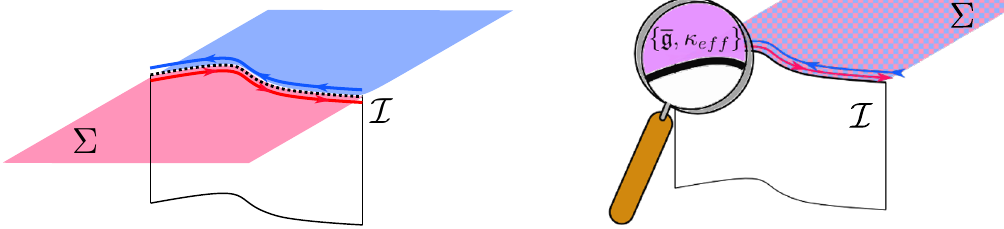
Figure 2 . On a Cauchy slice (cid:6) the bulk theory can be rewritten as a chiral WZW theory on either side of the interface. In the folded theory, we have a chiral and anti-chiral WZW whose restriction to ^ g close to the interface coalesces into a single non-chiral WZW consistent with the interface (now treated as a boundary) being